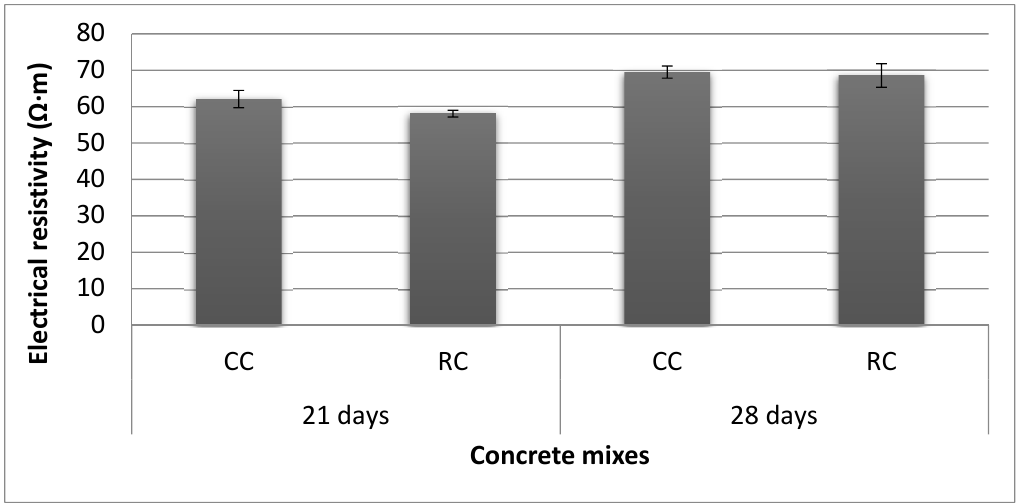
Figure 12. Electrical resistivity of the samples, control concrete (CC) and recycled concrete (RC).